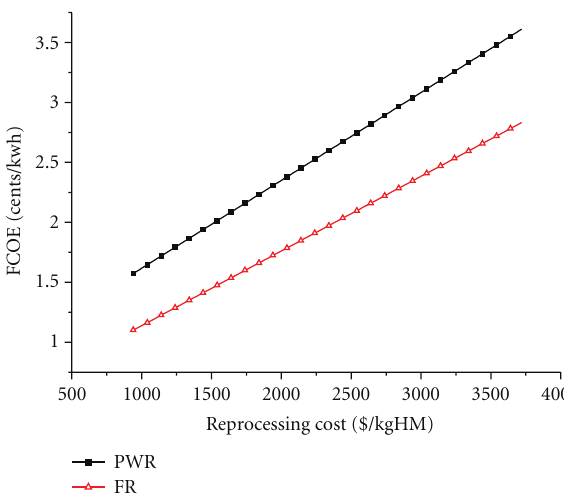
Figure 10: The changes of FCOE with reprocessing cost.